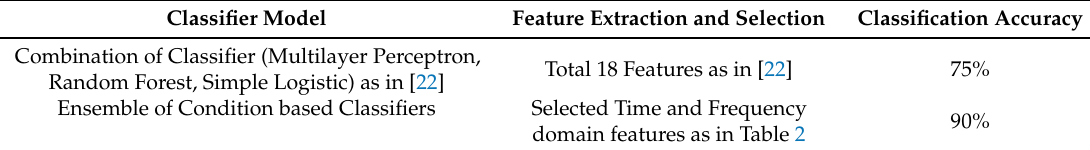
Table 7. Comparison of the proposed technique with a multi-classifier combination approach for detailed activity recognition as in [22] on the basis of classification accuracy, where the training dataset is D1-SPT and the test dataset is D5-SPT .